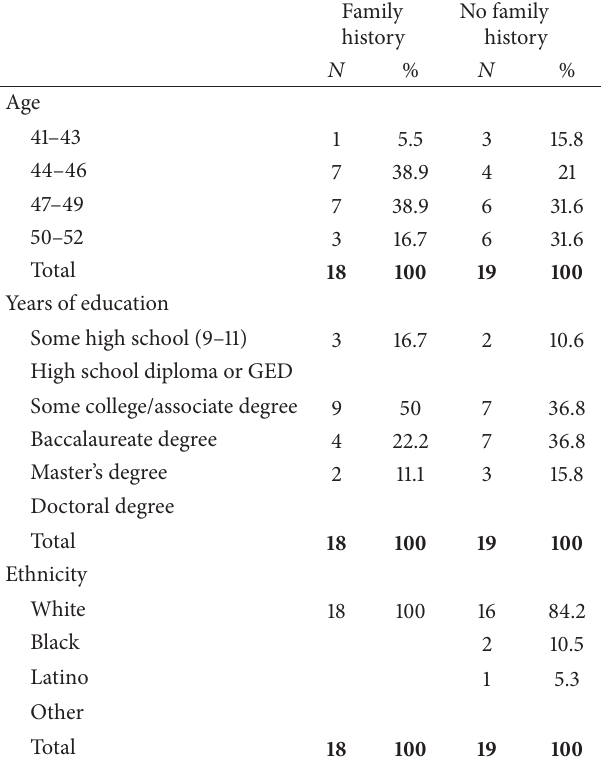
Table 1: Demographics.